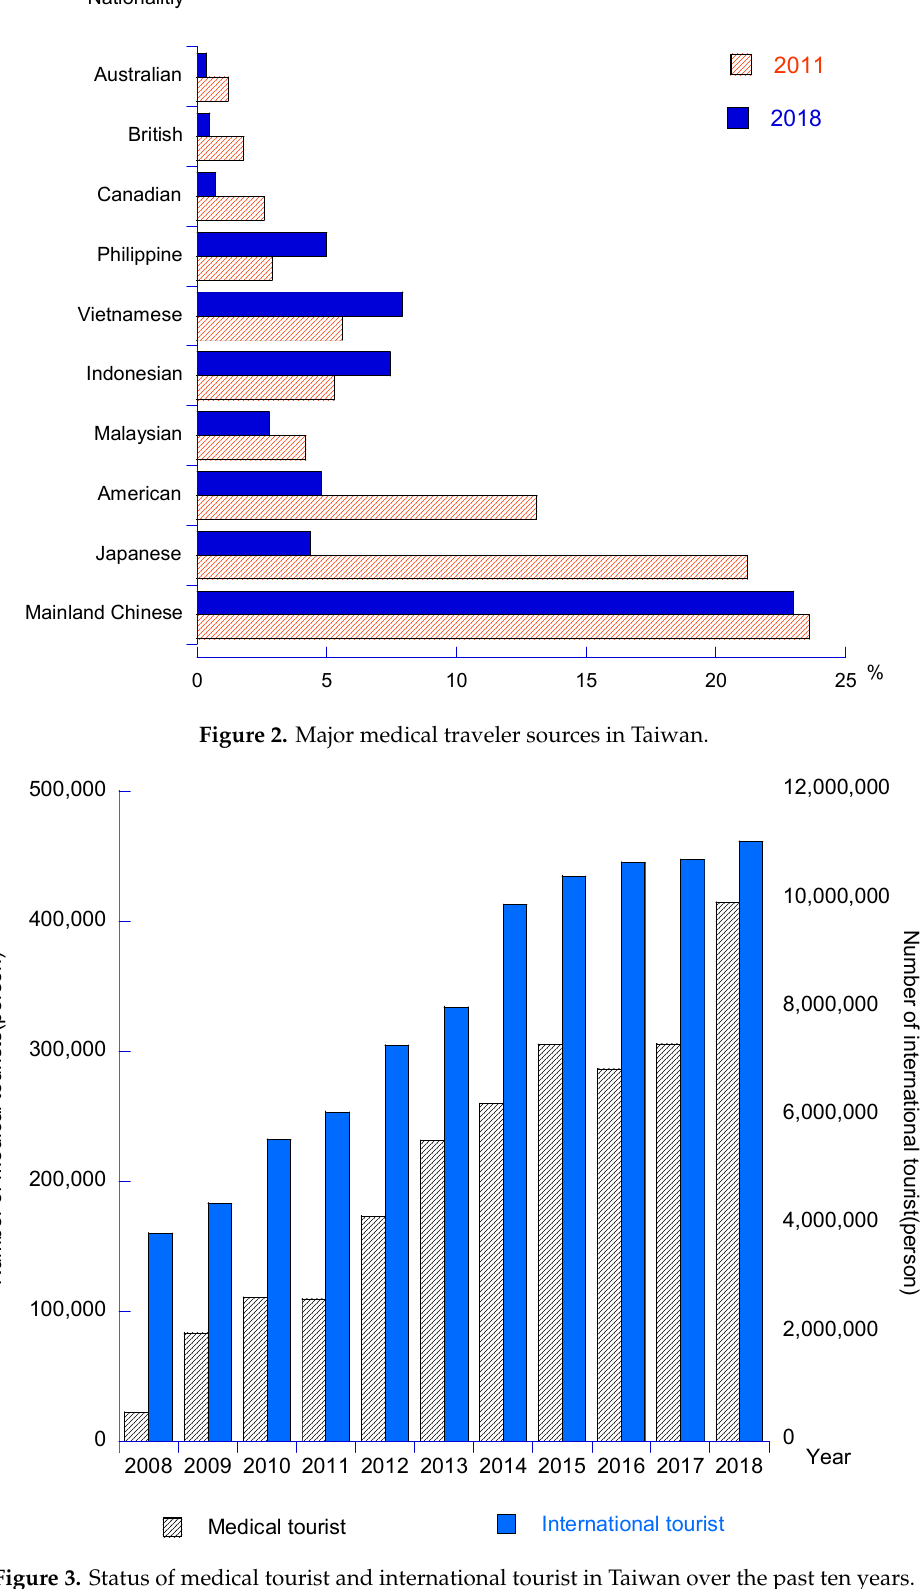
Figure 3. Status of medical tourist and international tourist in Taiwan over the past ten years.